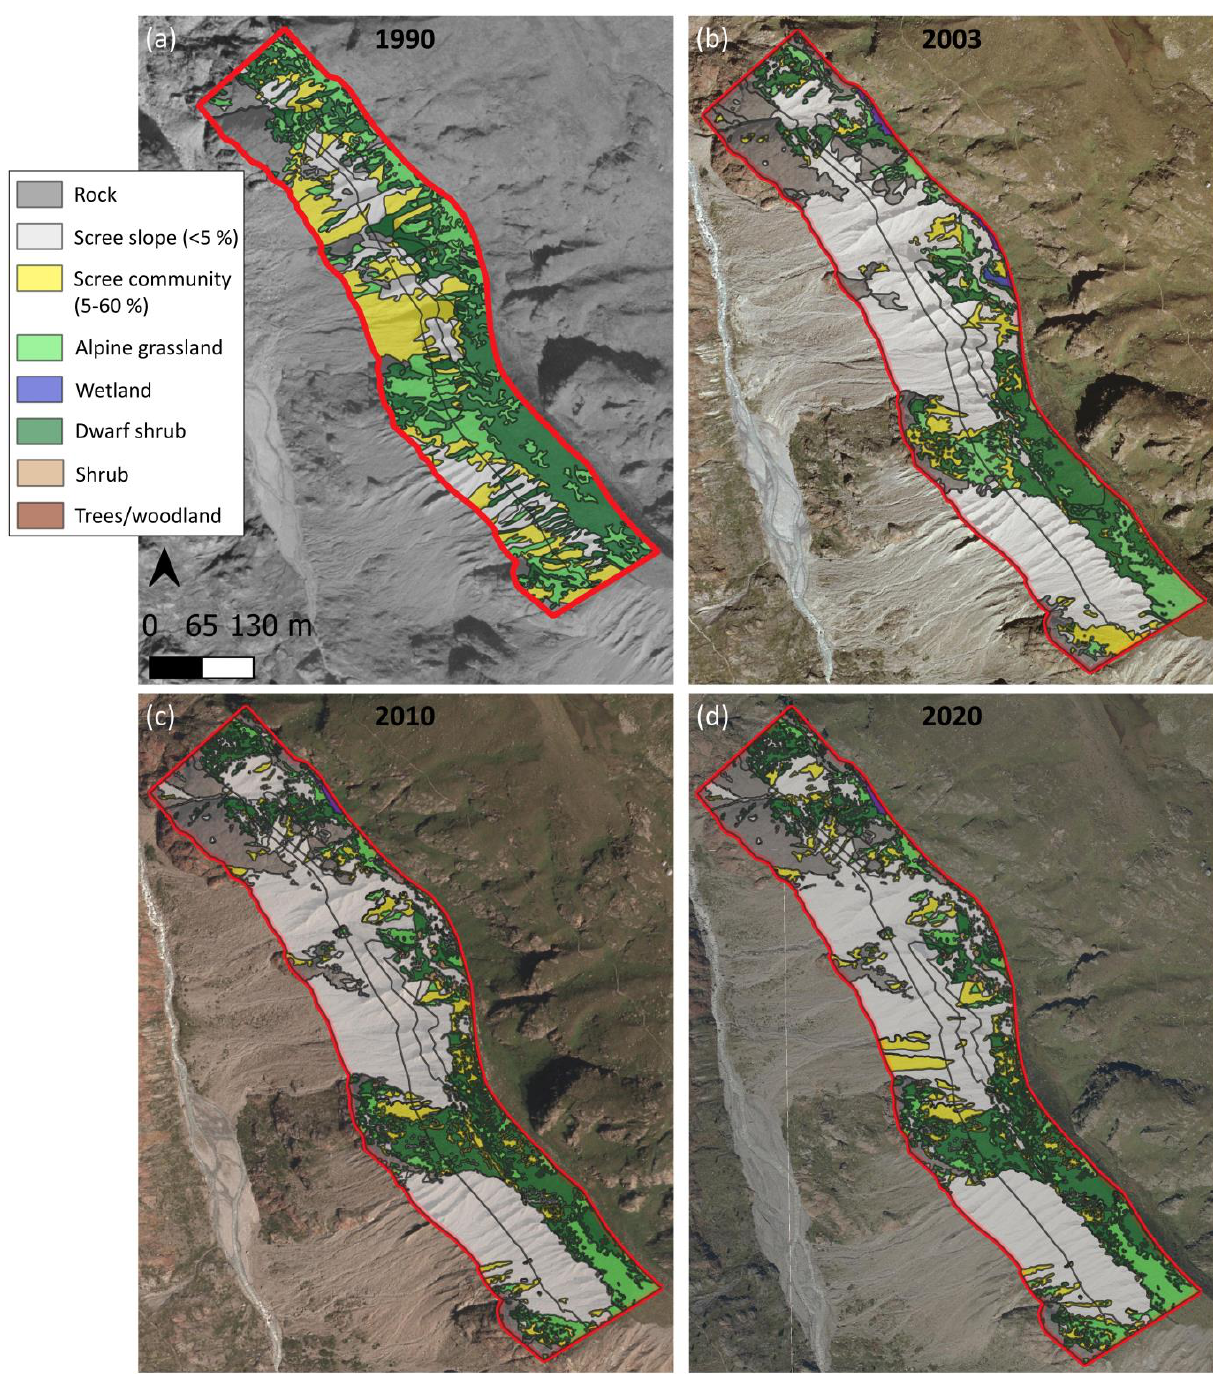
Figure A6. Continued mapping of the different surface types (land-cover mapping) using georeferenced orthophotos based on overlapping area-wide aerial photographs from 1990 to 2020 ( a – d ). The red line indicates the area of interest.